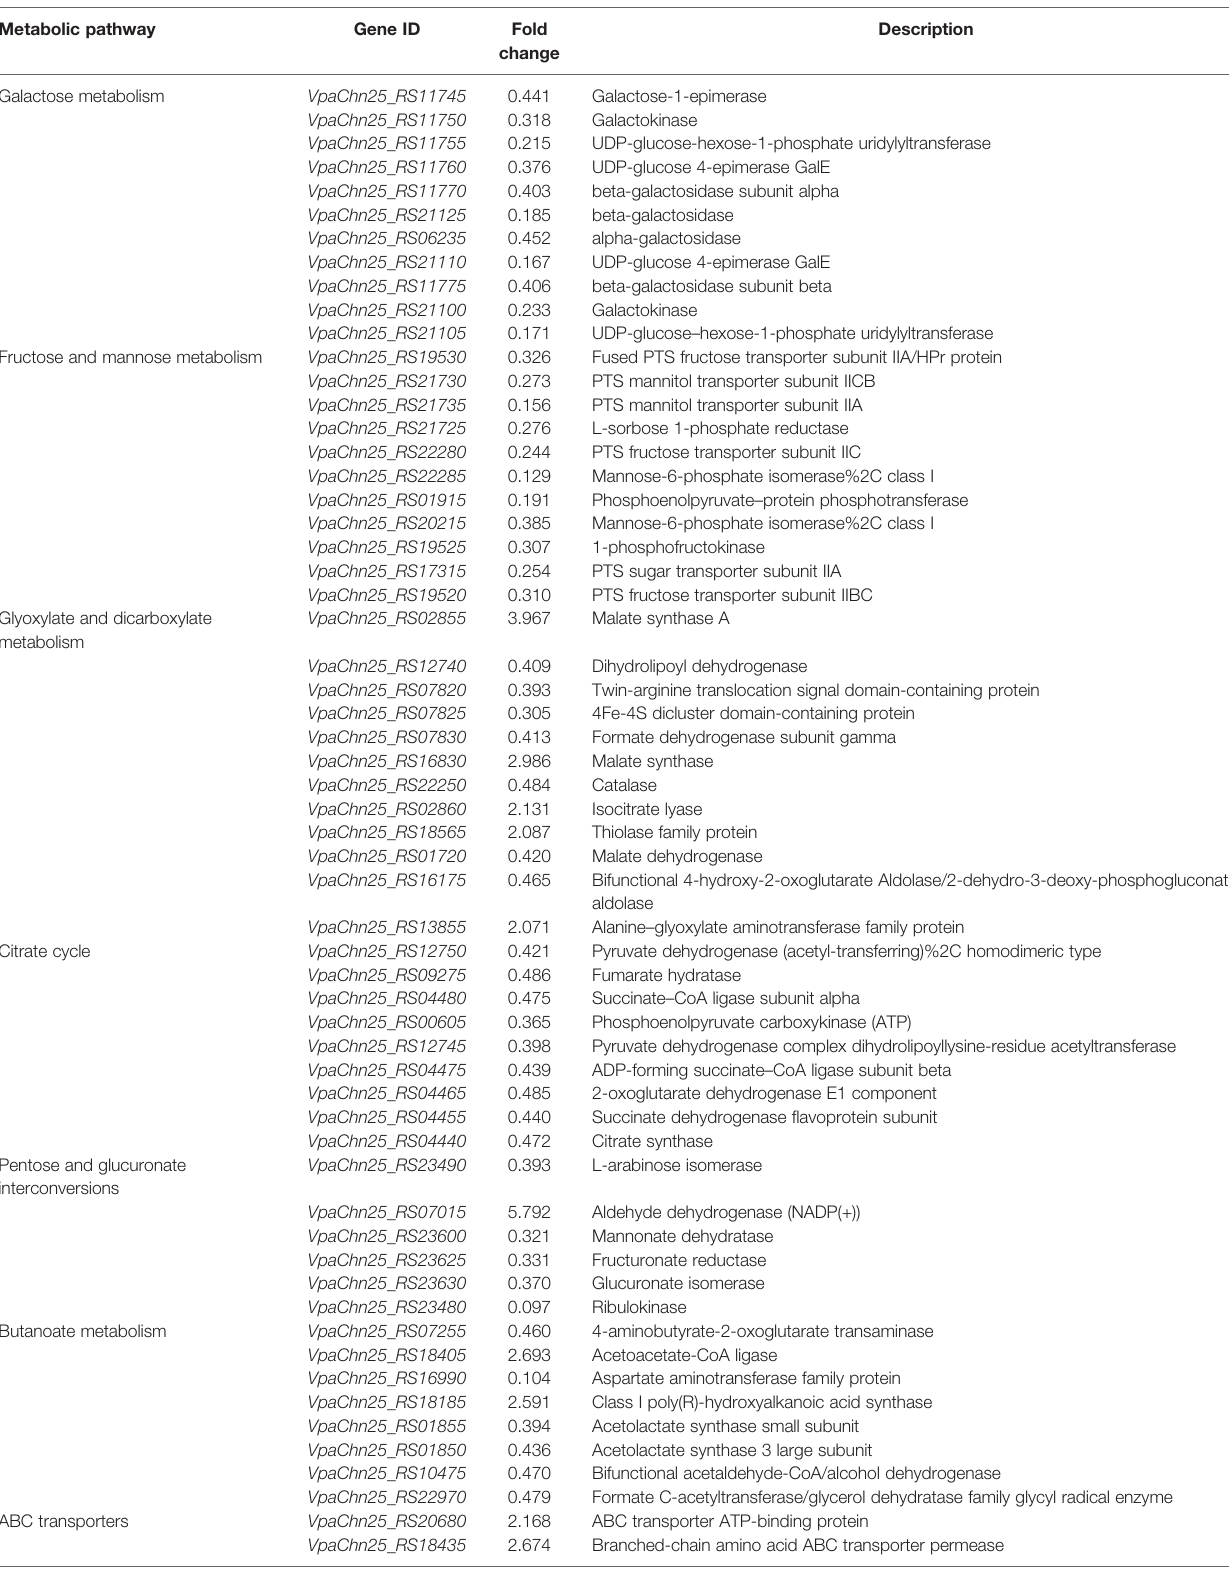
TABLE 3 | Major altered metabolic pathways in the D VpaChn25_0724 mutant. Metabolic pathway Gene ID Fold change